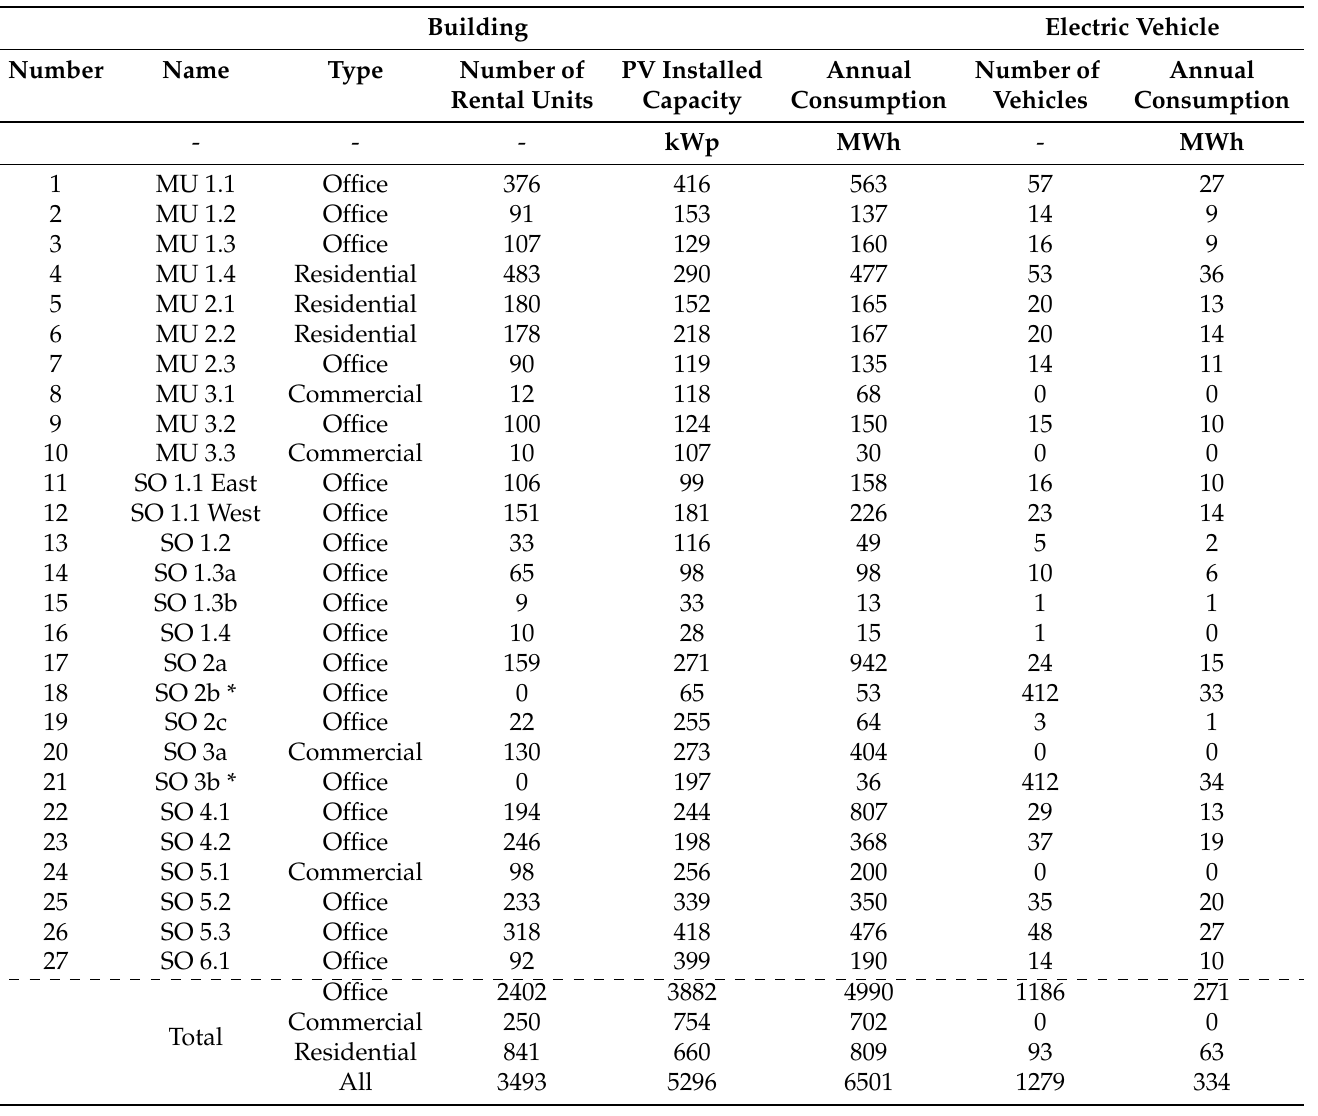
Table 1. Details of the studied